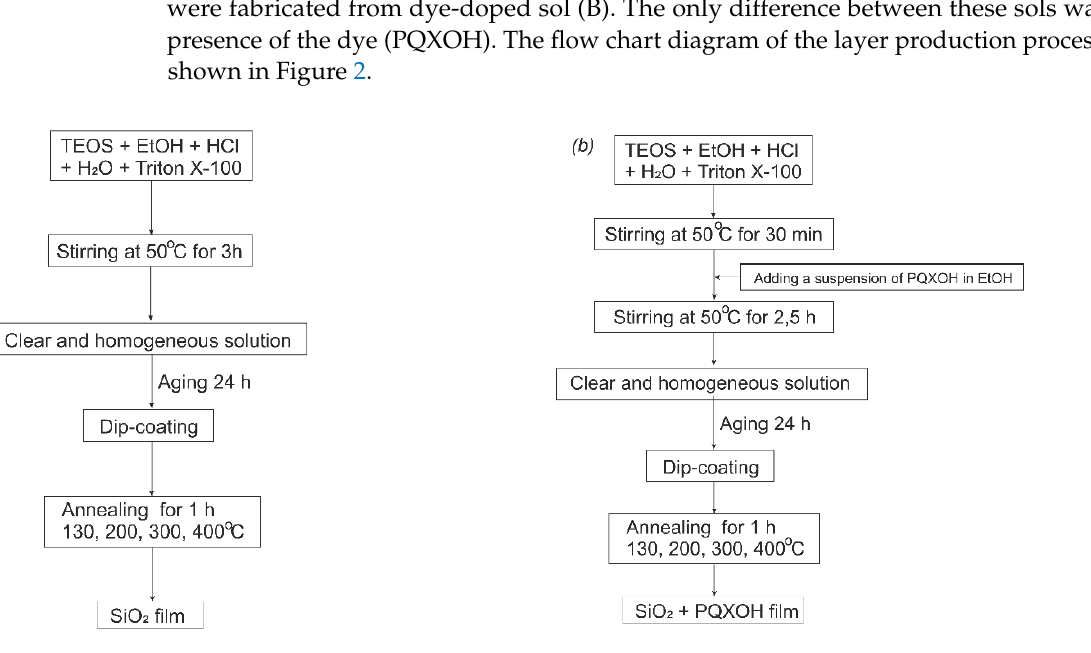
Figure 2. Diagram of the procedure for the production of thin layers from the reference silica sol ( a ) and silica sol doped with PQXOH ( b